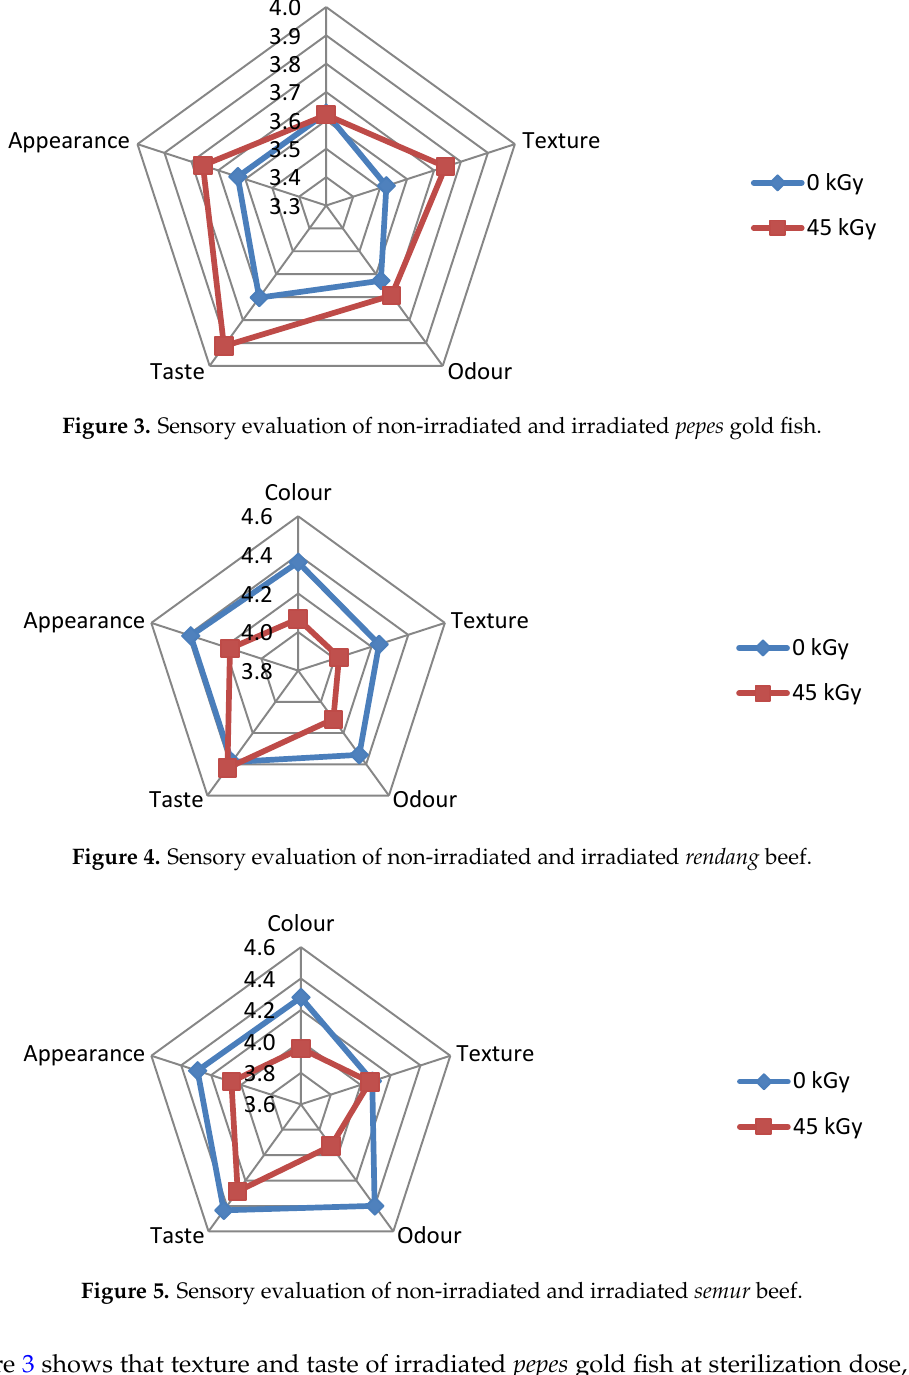
Figure 2. Sensory evaluation of non-irradiated and irradiated bacem tofu.